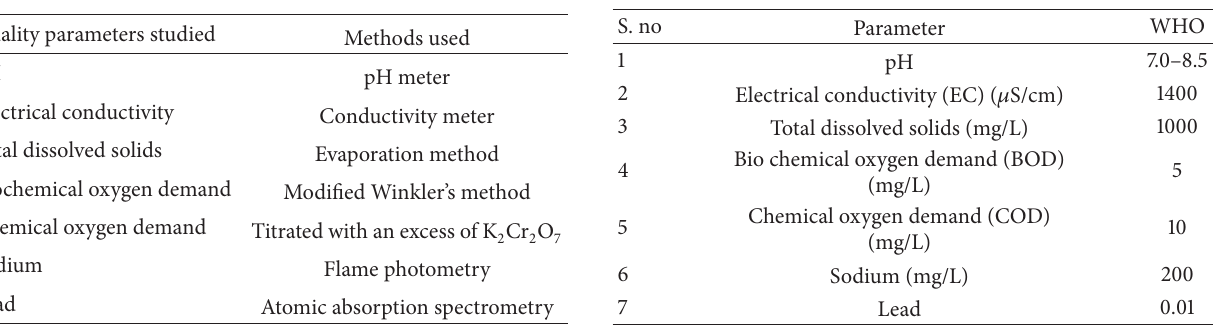
Table 3: Methods used for analysis of quality parameters for the water samples.